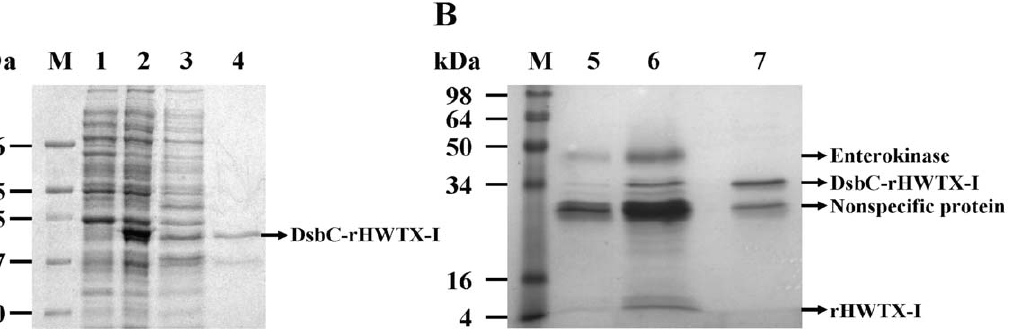
Figure 3. SDS-PAGE analysis. A) Lane M, protein molecular weight markers; lane 1, uninduced cell sample; line 2, induced cell sample; line3, total soluble proteins extracted from the periplasm of induced cells; line 4, purified fusion protein (arrow indicates DsbC-rHWTX-I). B) Lane M, protein molecular weight markers; lane 5, 20 m l DsbC-rHWTX-I after enterokinase digestion; lane 6, 100 m l DsbC-rHWTX-I after enterokinase digestion; line 7, negative control (10 m l DsbC-rHWTX-I, enterokinase